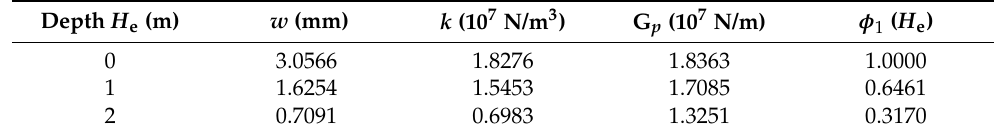
Table 3. Results for a beam embedded in a Gibson elastic foundation ( η 2 = 2). Depth H e